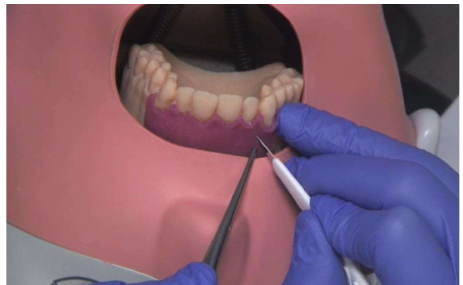
Figure 6. Surgical incision guidance on the 3D-printed model in the phantom.